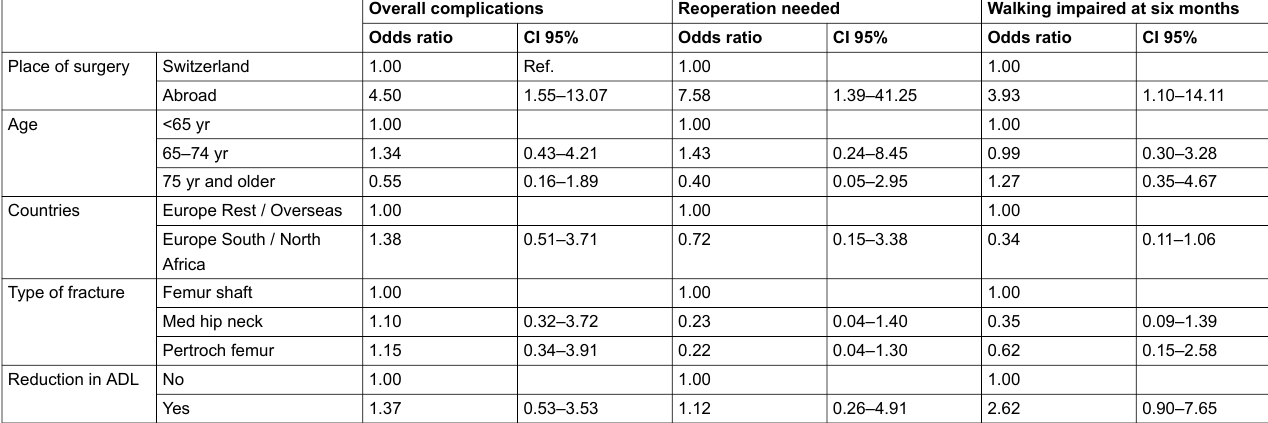
Table 6: Predictors of complications (multivariate analysis with logistic regression. Overall complications Reoperation needed Walking impaired at six